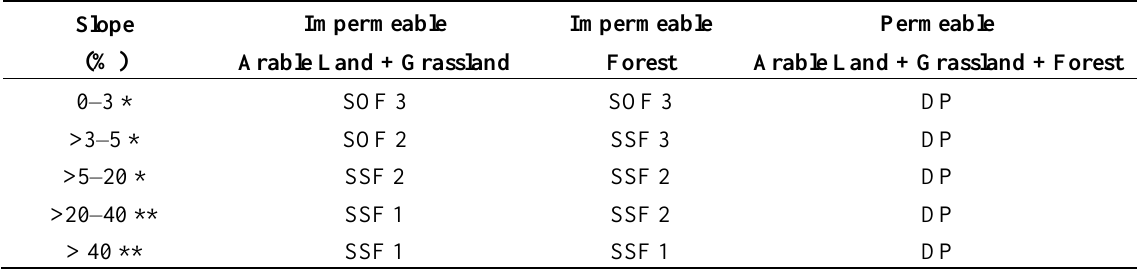
Table 2. Geographic information system-dominant runoff processes (GIS-DRP) basic table; DRP regarding the slope, the geological substratum and the land use (based on Müller et al. [14],